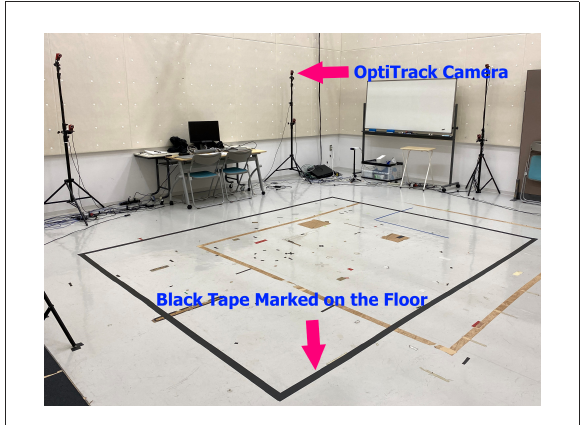
FIGURE3 Rectangular walking area marked with black tape on the floor.